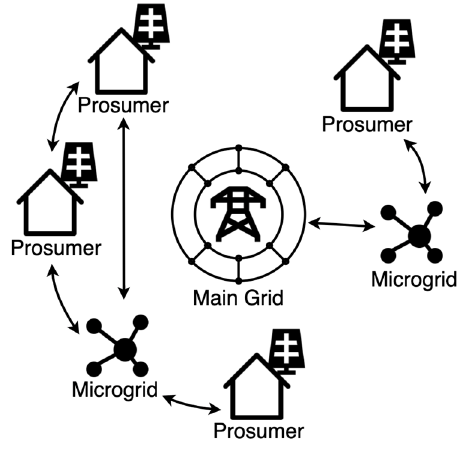
Figure 1. Hybrid Approach to Energy